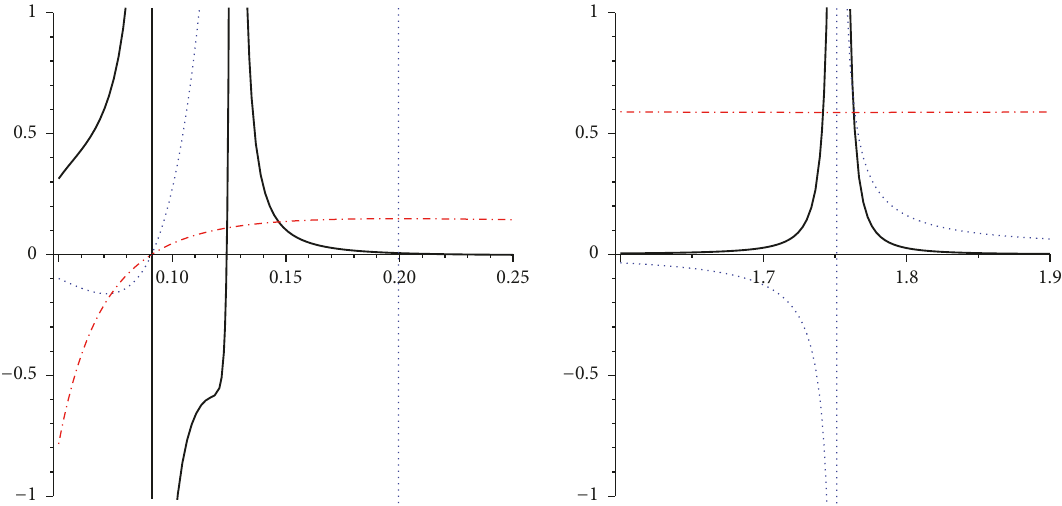
Figure 2: Ruppeiner metric. R (continuous line), 𝐶 𝑄 (dotted line), and 𝑇 (dot dashed) versus 𝑟 + for Λ = −1 , 𝑛 = 4 , 𝑞 = 0.1 , 𝑏 = 1 , 𝜔 = 10 , and 𝛽 = 1.5 . “Note: both panels are plotted with the same parameters, but different regions and